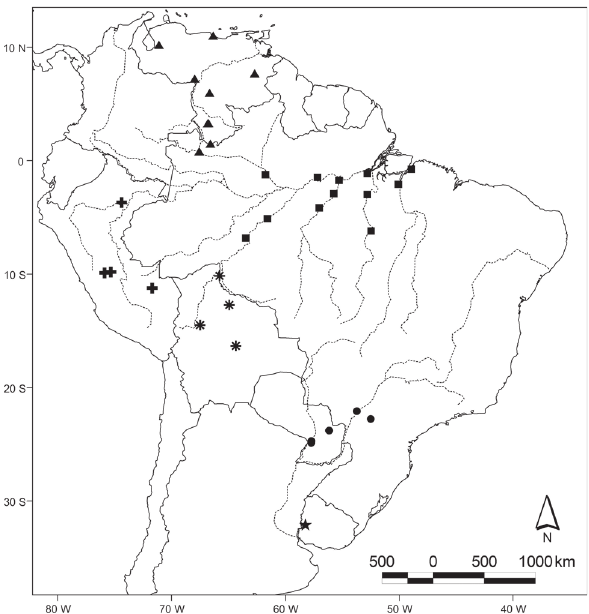
Figure 1. Geographic mapping of samples analyzed in the present study: (  ) Uruguay, (  ) Paraná, (  ) Bolivia, (  ) Peru, (  ) Ama- zon, and (  )